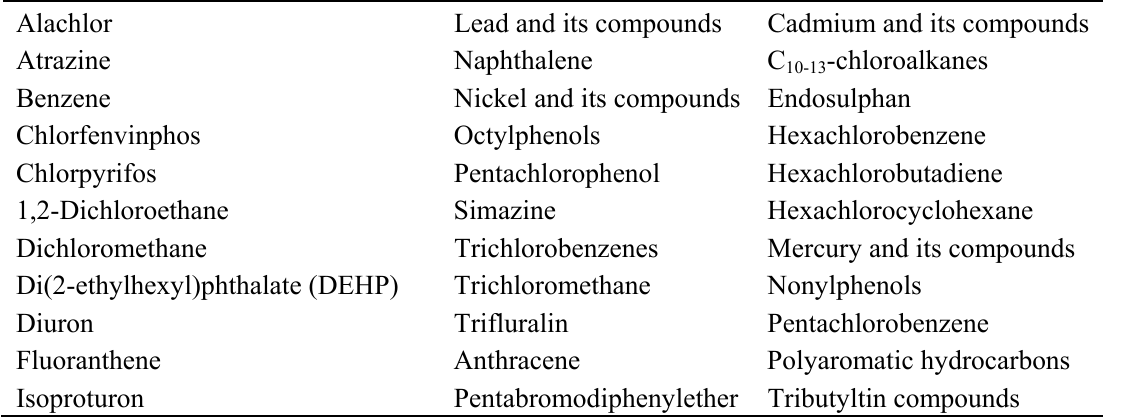
Alachlor Lead and its